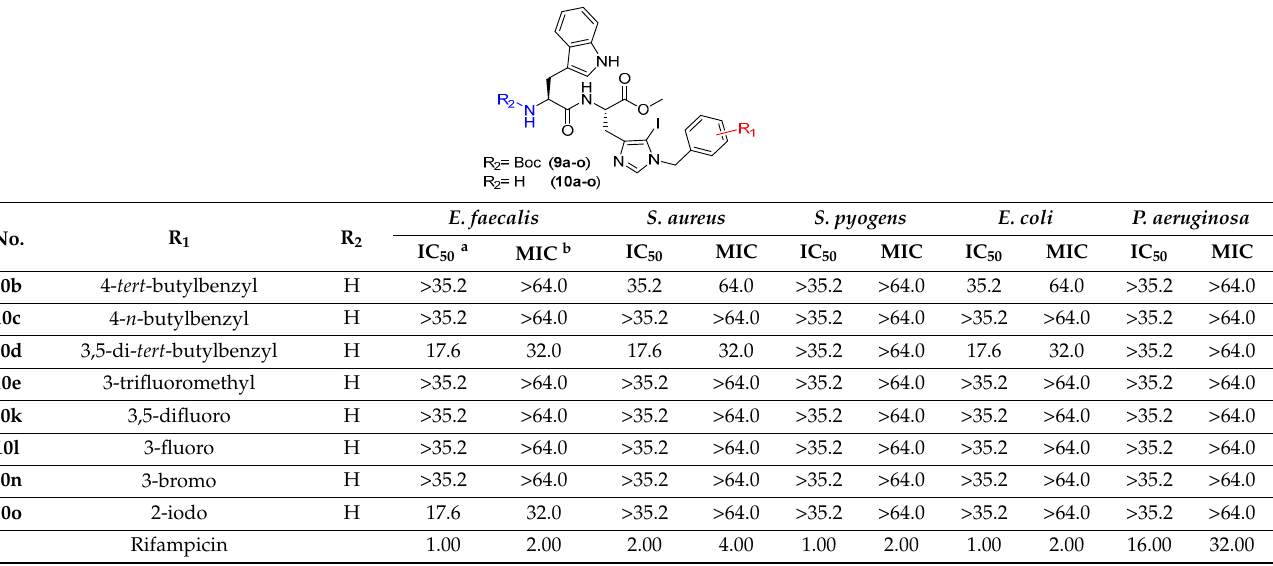
Table 3. In vitro antibacterial screening of peptides (Series 1–2).